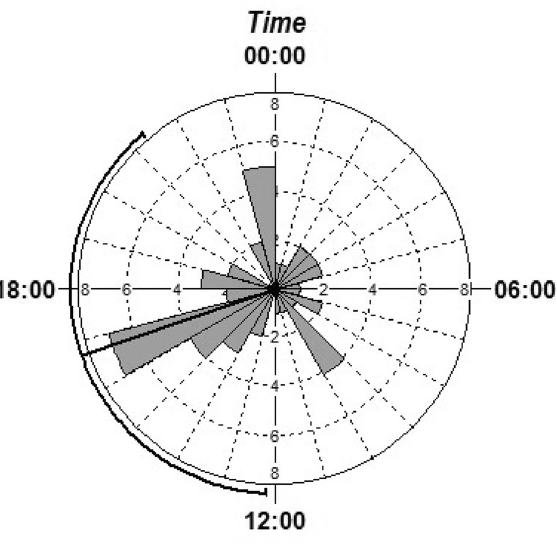
Figure 2. Circadian activity of the Western Derby elands in the Niokolo Koba National Park, Senegal. Each wedged-shaped column of histogram indicates the number of events at the indicated time, while the black line indicates the mean activity vector and 95% confidence